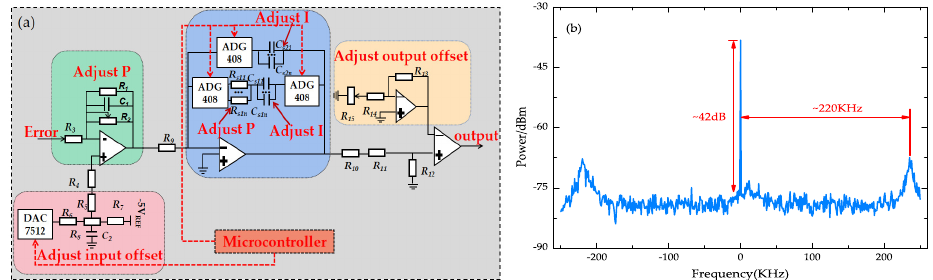
Figure 2. ( a ) Design of the fast PI control loop; ( b ) noise suppression range of the fast PI